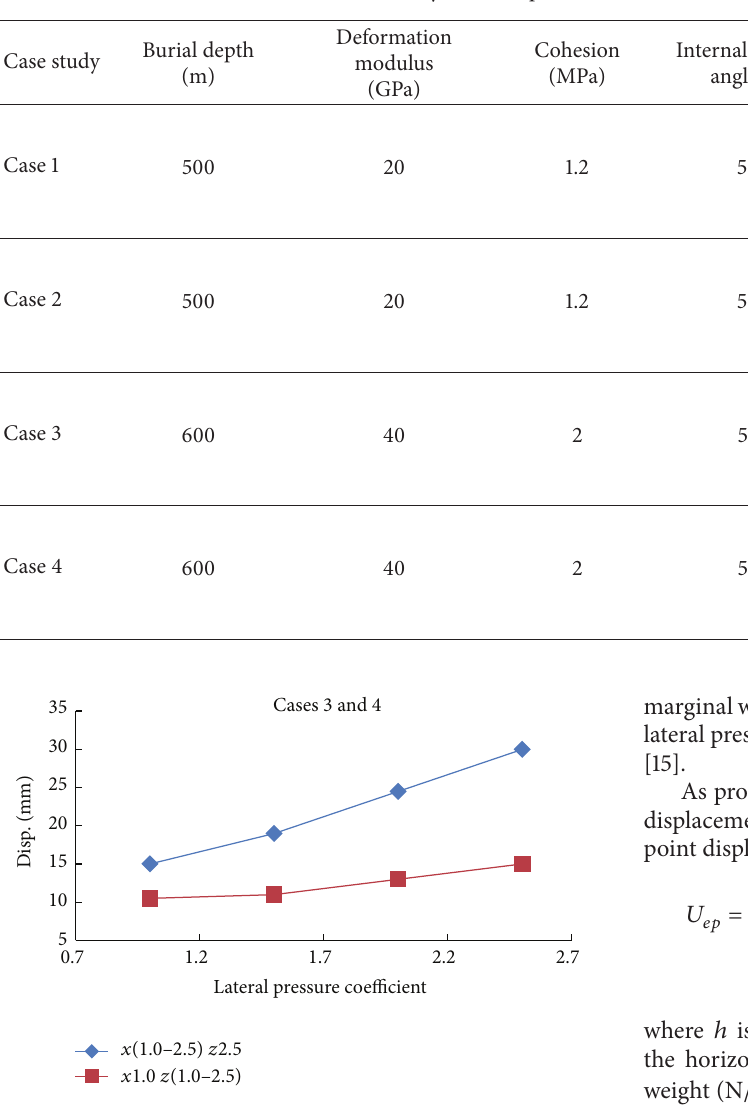
Table 5: Case study of lateral pressure coefficient on stability of cavern side wall.